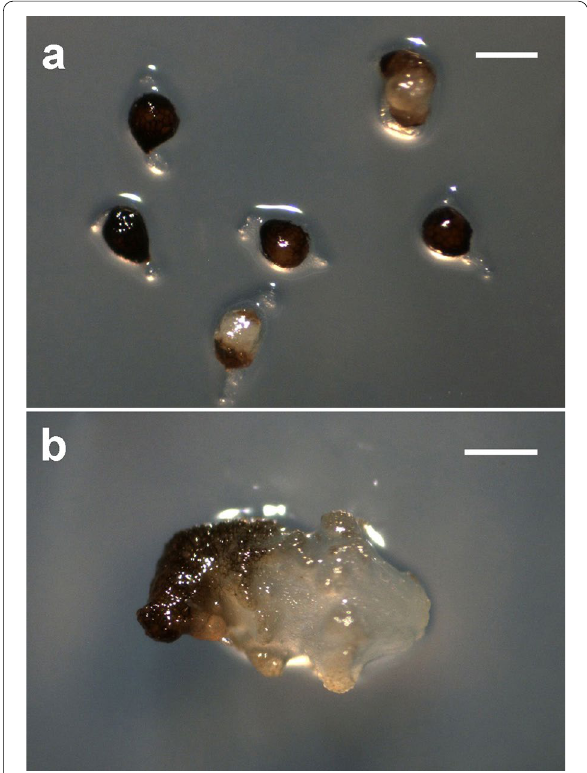
Fig. 4 The successive developmental stages of N. singapureana from seed germination to protocorm formation in asymbiotic culture in vitro. a Light micrograph showing the stages of no growth of embryo and embryos emerging from the seed coat. Bar b Light micrograph showing a developing rhizome‑like